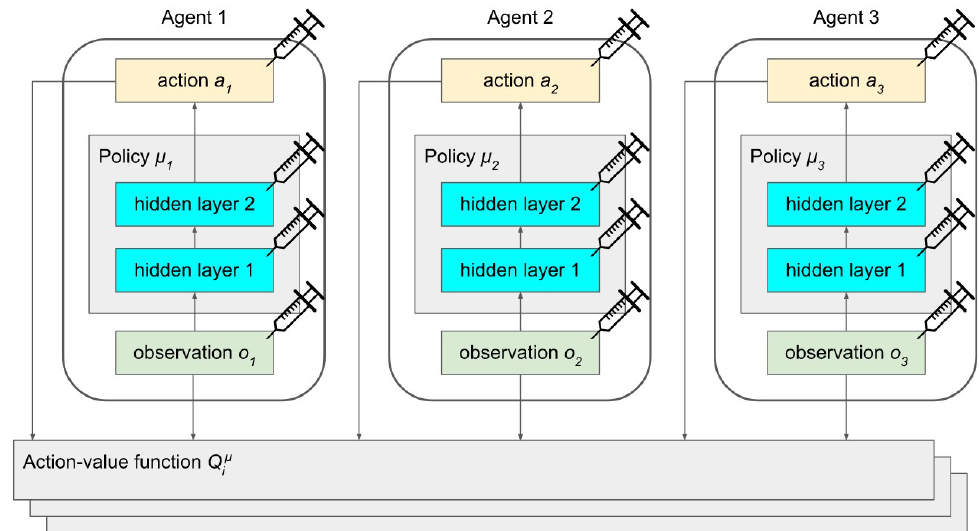
Figure 2. The centralized training decentralized execution framework proposed in the multi-agent deep deterministic policy gradien (MADDPG) algorithm. The action–value function Q µ i makes use of observations and actions of all agents but is used only at training time. During the evaluation, the policy function µ i for each agent i depends only on the agent’s local observation o i when producing action a i . In this work linear probes depicted by syringe are used at observation, hidden layer 1, hidden layer 2, and action level to predict the final landmark of other